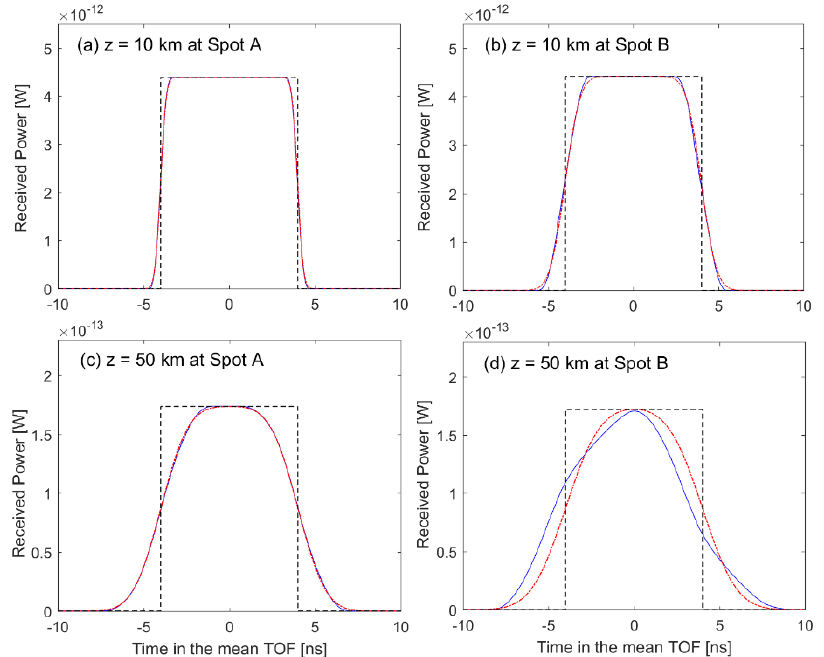
Figure 5. Backscattered waveform for a transmitted rectangular pulse at four locations. The blue solid line represents the full waveform, the red dash-dotted line represents the analytical waveform to apply the broadened pulse width estimated from a Gaussian fitting, and the black dashed line corresponds to the transmitted pulse width.